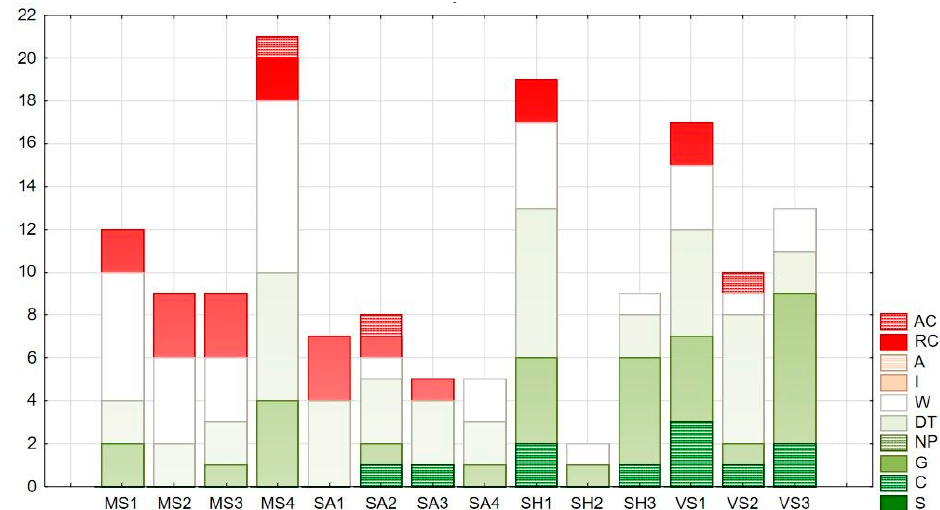
Figure 3. Distribution of herbaceous species by social behavior type (SBT) categories.